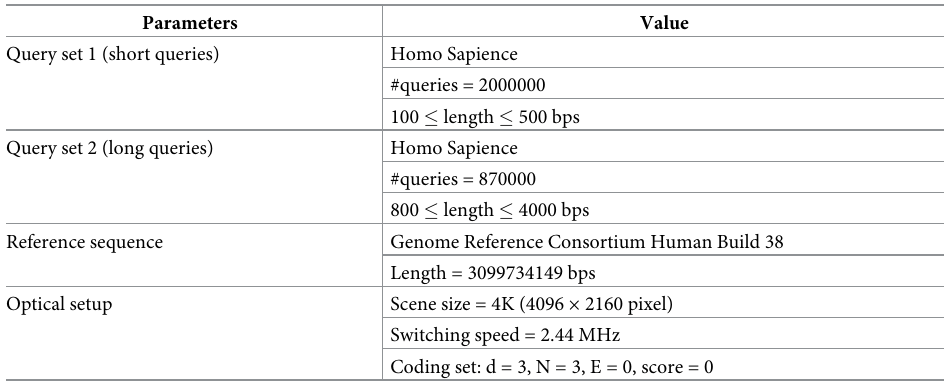
Table 10. Assumptions of speed comparison assessment.